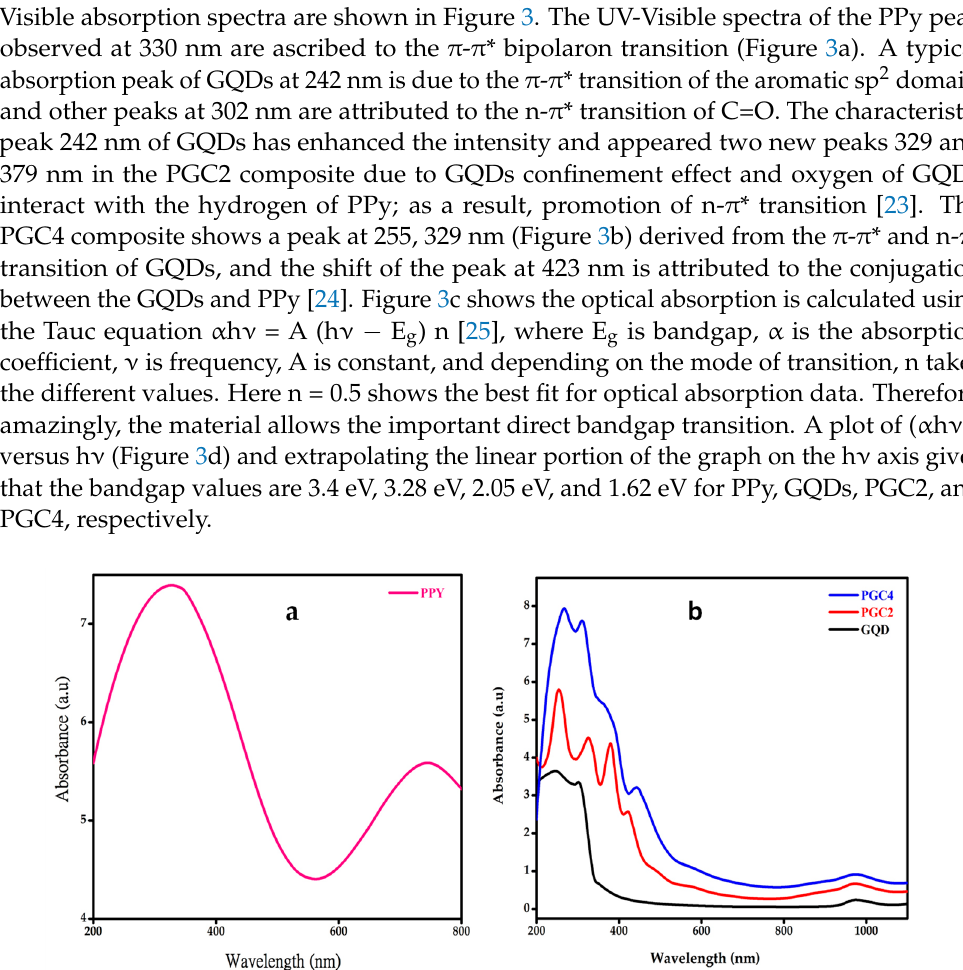
clarify the GQDs allocation